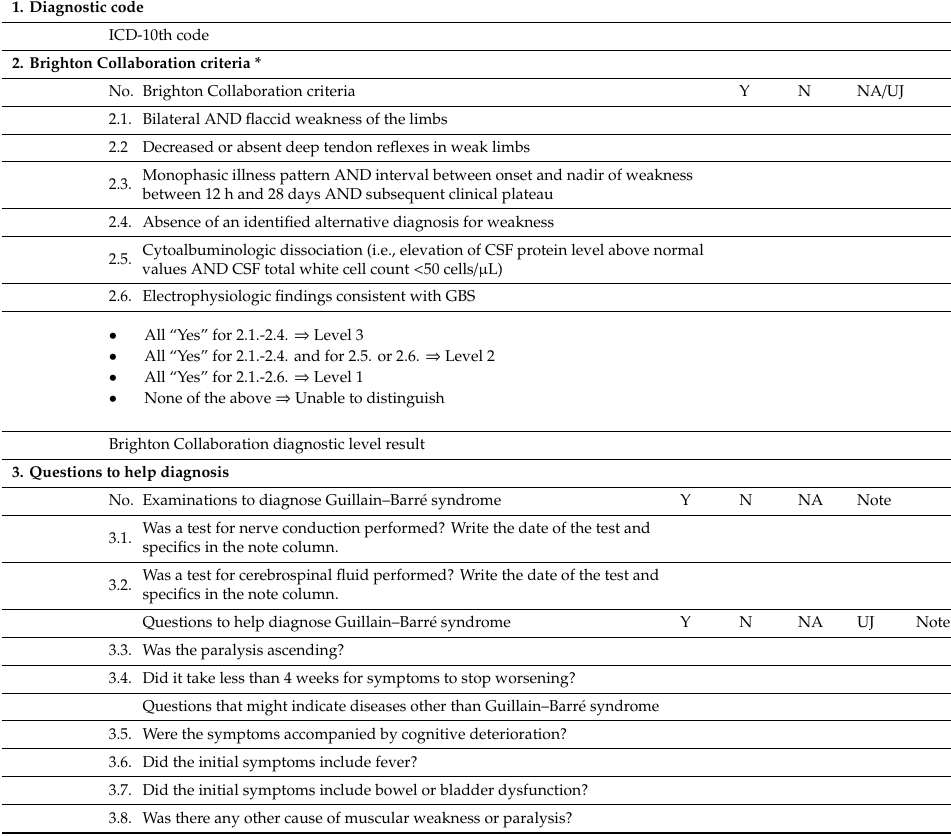
Table 1. Case ascertainment of Guillain–Barré syndrome.